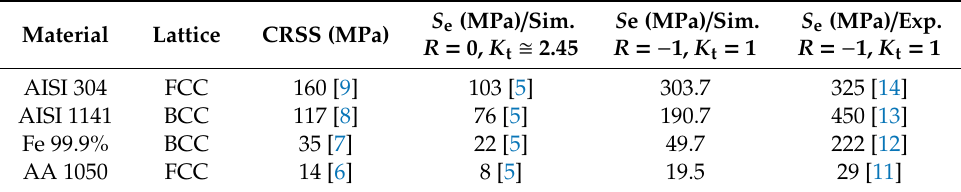
Table 2. Simulation-based endurance limits ( S e ) from [5] of the investigated materials in comparison with experimental values ( S e values are expressed in terms of nominal stress amplitude S a ). For details on how to deduct S e values for R = − 1 and K t = 1 (axial loading), see Appendix